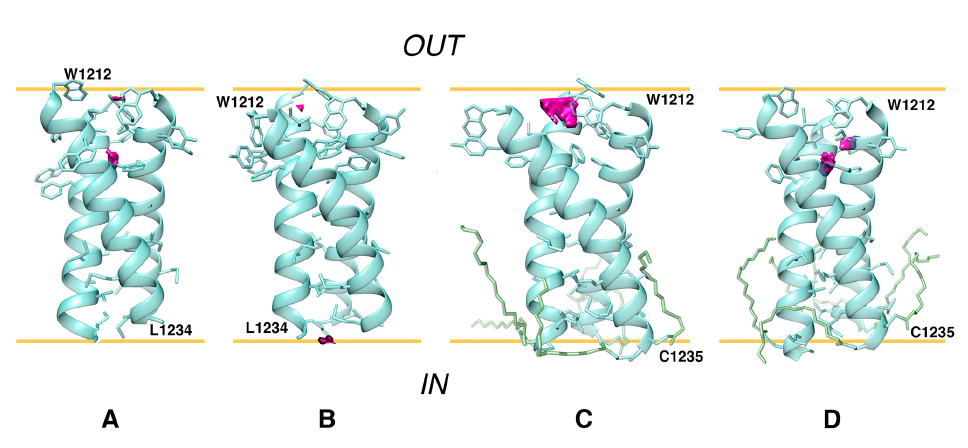
Figure 6. Visualization of free volume in unpalmitoylated and palmitoylated S _ OPT . Free volume in the lumen of the model trimers is rendered as pink blocks (averaging over 200 frames not applied) and shown at 1 µ s of MD trajectories S _ OPT run1 ( A ), S _ OPT run2 ( B ), S _ OPT-PLM run1 ( C ), and S _ OPT-PLM run2 ( D ). 3D models are shown in cartoon/stick representation; palmitoyl chains are shown in stick representation where present. Approximations of POPC carbonyl/ester oxygen planes are shown as yellow lines. The inside of the virion and the external environment are designated as “IN” and “OUT,”